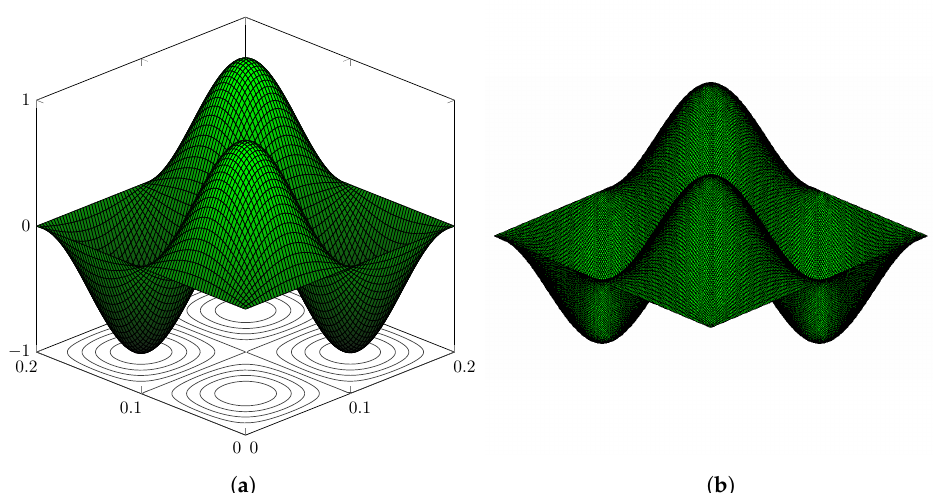
Figure 5. Simply supported LRMP in Figure 3, real part of Mode 130: ( a ) dynamic-stiffness approach and ( b ) finite-element method.